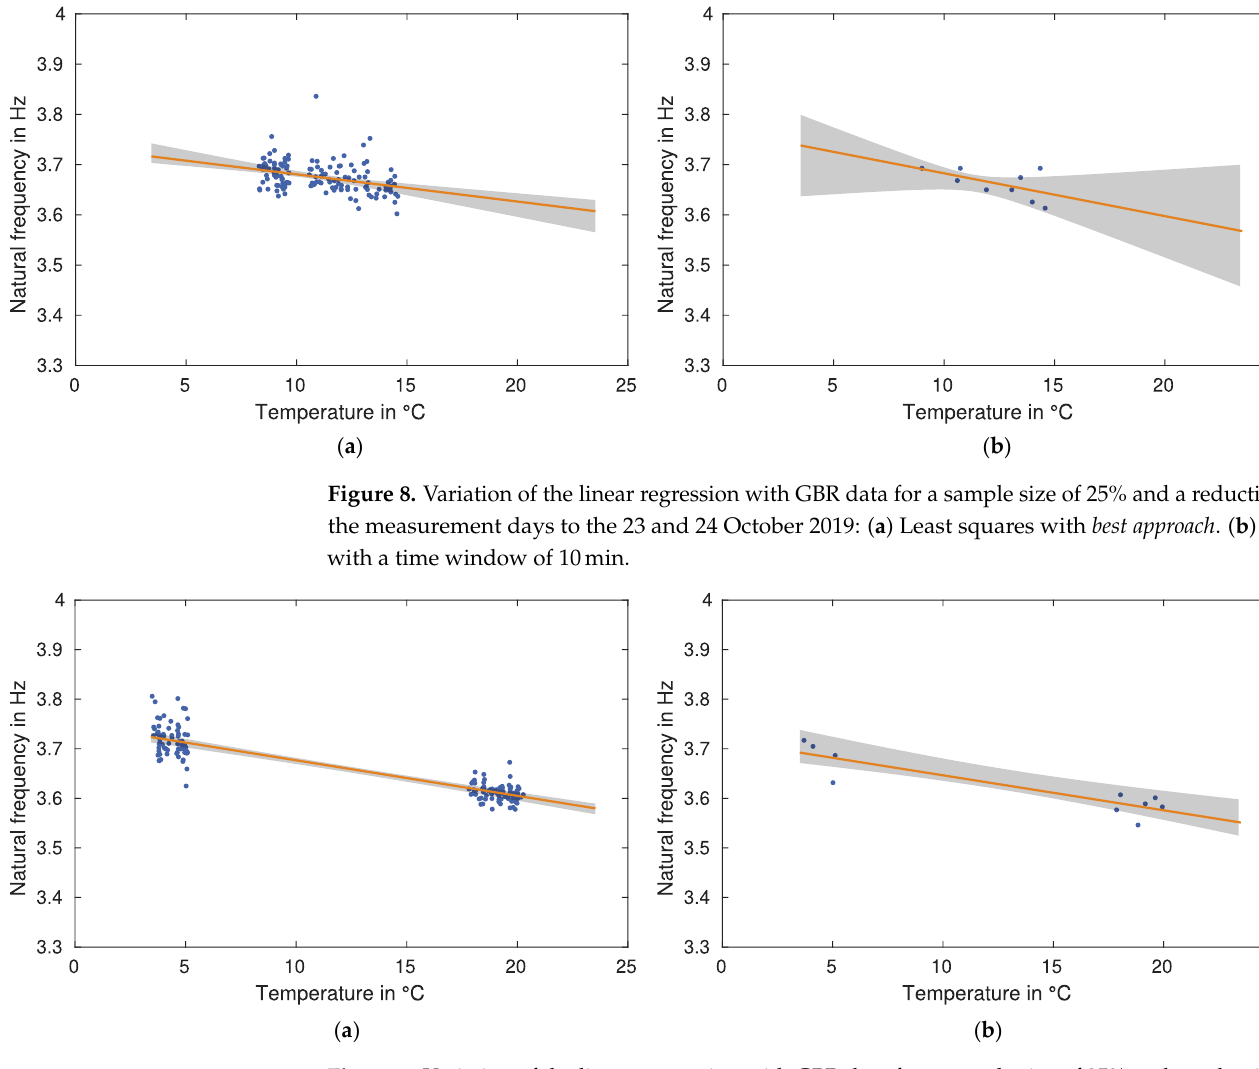
Figure 9. Variation of the linear regression with GBR data for a sample size of 25% and a reduction of the measurement days to the 27 February 2020 and 29 July 2020: ( a ) Least squares with best approach . ( b ) FDD with a time window of